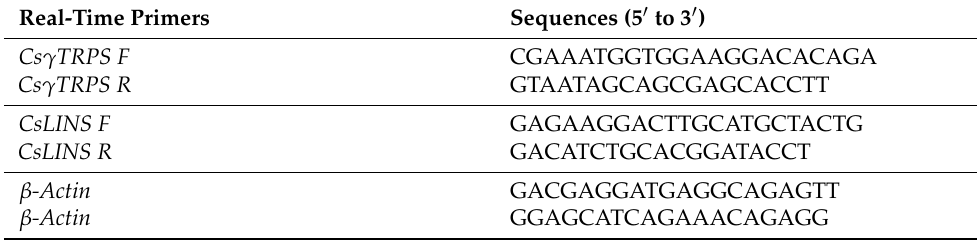
Table 1. Primers used for qRT-PCR